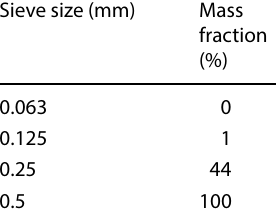
Table 1 Particle size distribution of Quartz sand H33